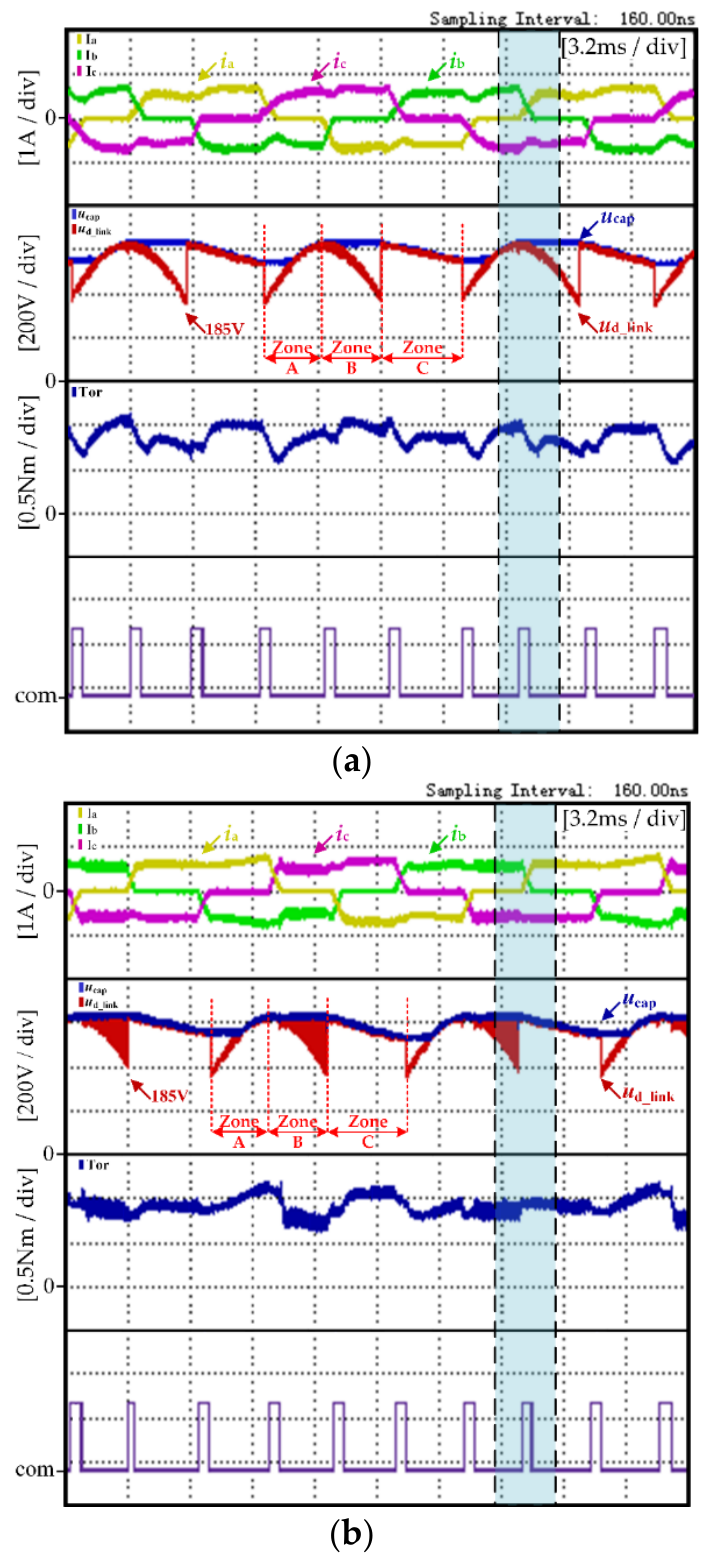
Figure 9. Experimental results under the high-speed condition (600 r/min, 0.89 N·m): ( a ) traditional strategy ( b ) proposed strategy.